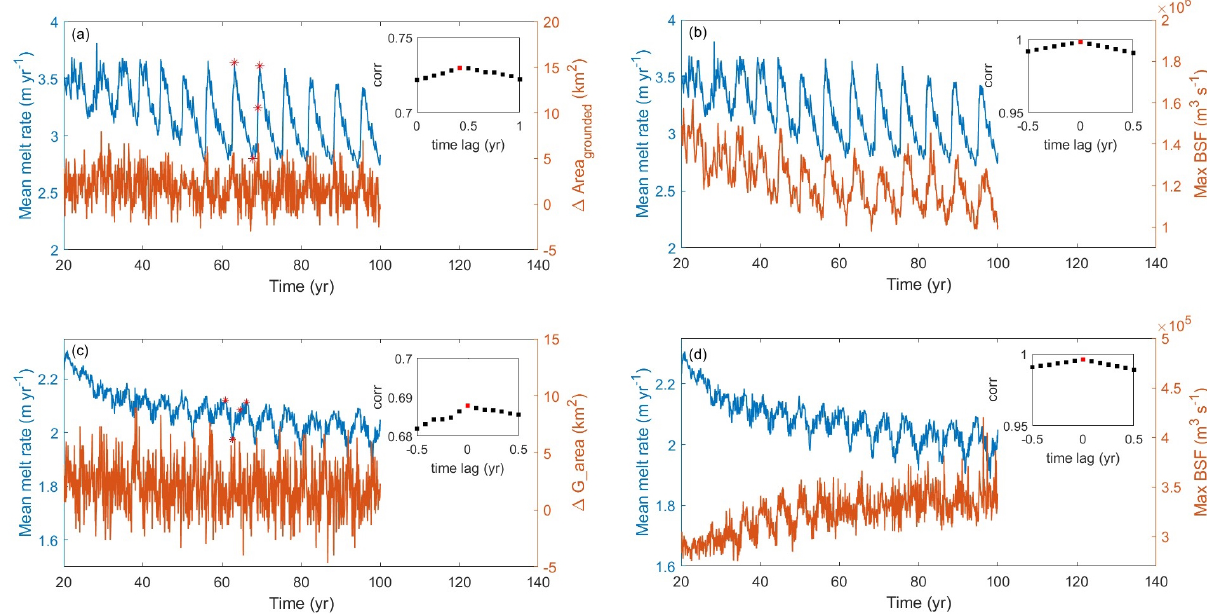
Figure 3. Mean melt rate and the moving mean changes in grounded areas from (a) CTRL and (c) Ocean3, mean melt rate and maximum of the barotropic stream function from (b) CTRL, and (d) Ocean3 starting from year 20. The correlation coefficients between the blue line and the orange line are shown in the inset of each panel, with the red dots indicating the highest correlation coefficient. A normalized passband frequency of 0.90 is applied to remove noise.